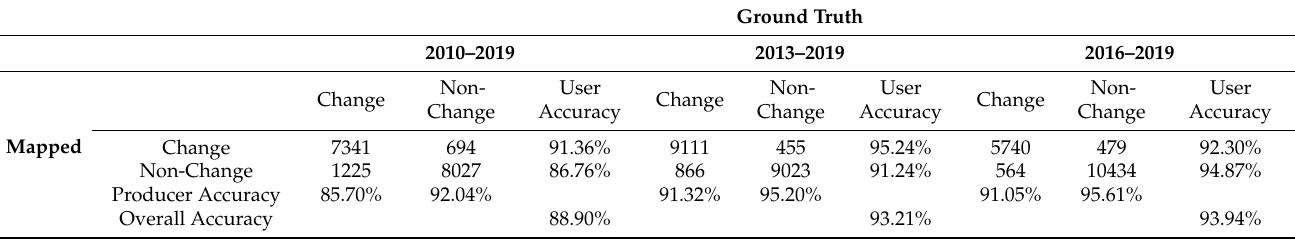
Table 5. Accuracy assessment of change area and non-change area.